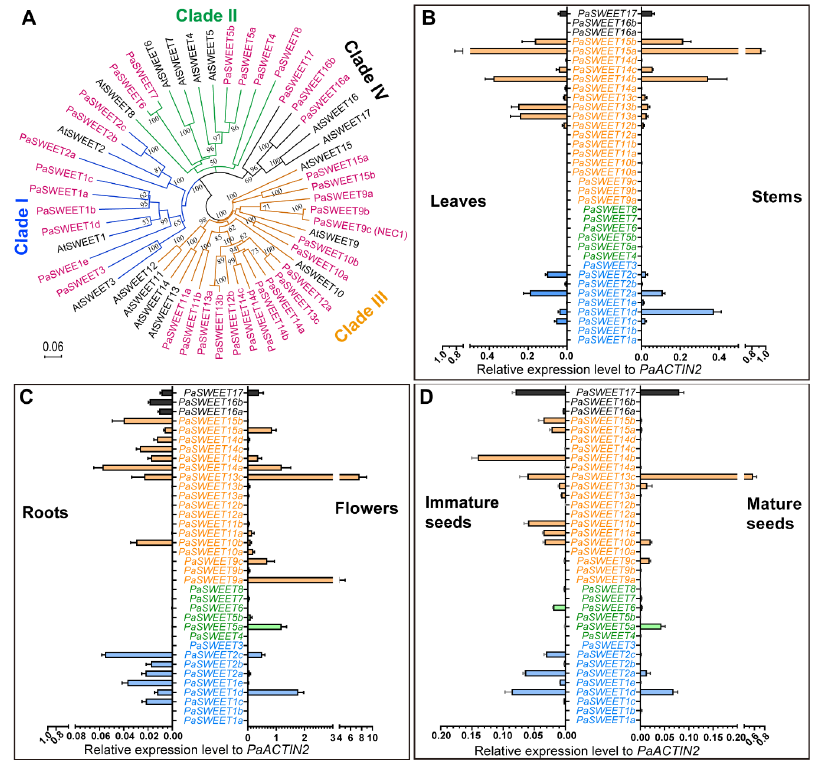
Figure 2. Phylogenetic analysis and tissue-specific expression profile of the P. axillaris SWEET transporters. ( A ) The 36-gene family of SWEET proteins are grouped into four clades (depicted in colored branch lines) together with the well-annotated Arabidopsis transporters. Sequence alignment and analysis are conducted using MUSCLE with default parameters, and the neighbor-joining (NJ) tree is constructed using MEGA X with 1000 bootstrap replications and visualized via Figtree version 1.4.4, with bootstrap value greater than 50% shown. The scale bar represents the ammino acid substitution rate per site. ( B – D ) Tissue-specific gene expression analysis of the SWEET genes via quantitative real-time PCR. Data are mean of 3 biological replications with the error bars representing